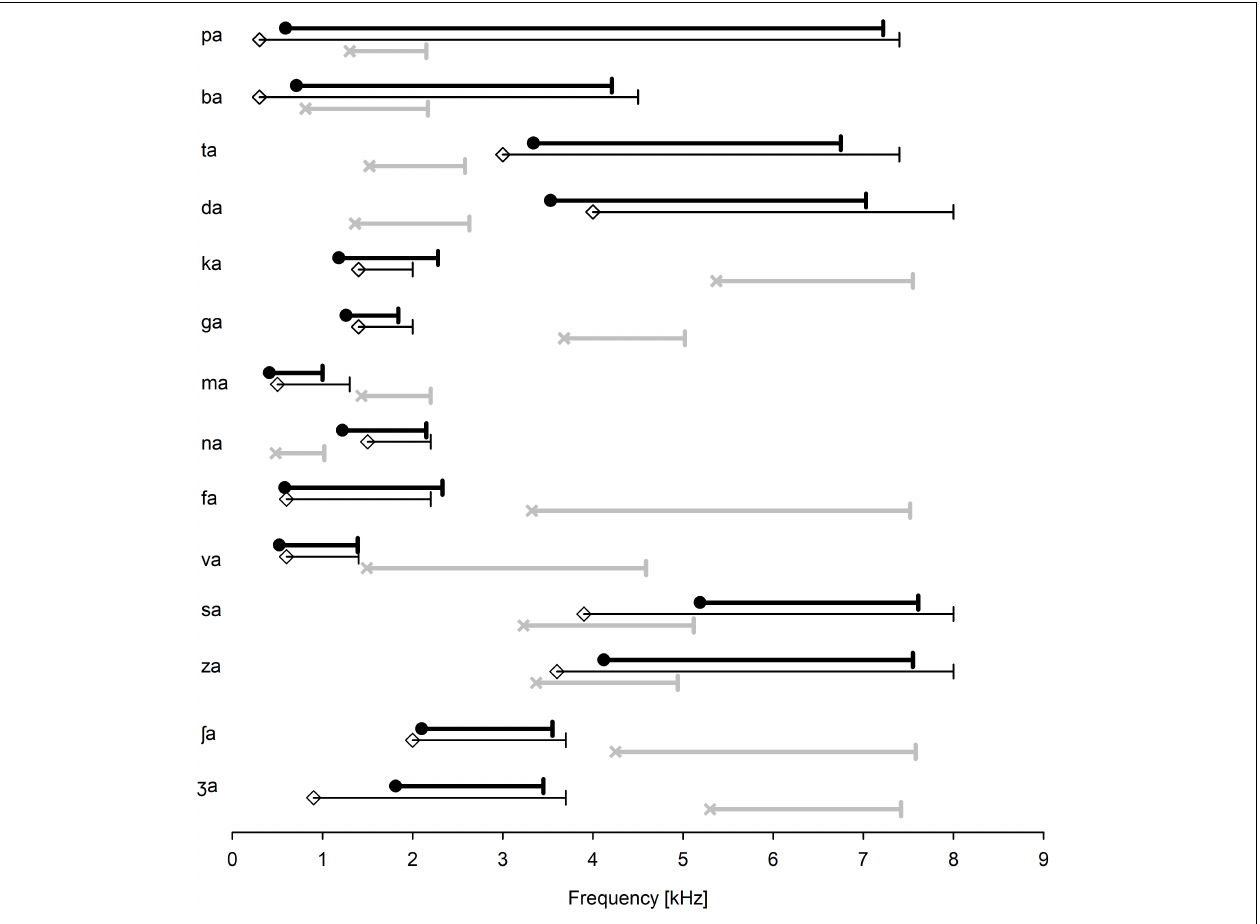
FIGURE 2 | The mean target (filled circles) and conflicting ( × symbols) frequency ranges for each consonant. Three consonants (/pa, ba, za/) have a partial or complete overlap between the target and conflicting frequency ranges. For comparison, the target frequency ranges, as reported by Li et al. (2010, 2012), are also presented (open diamond